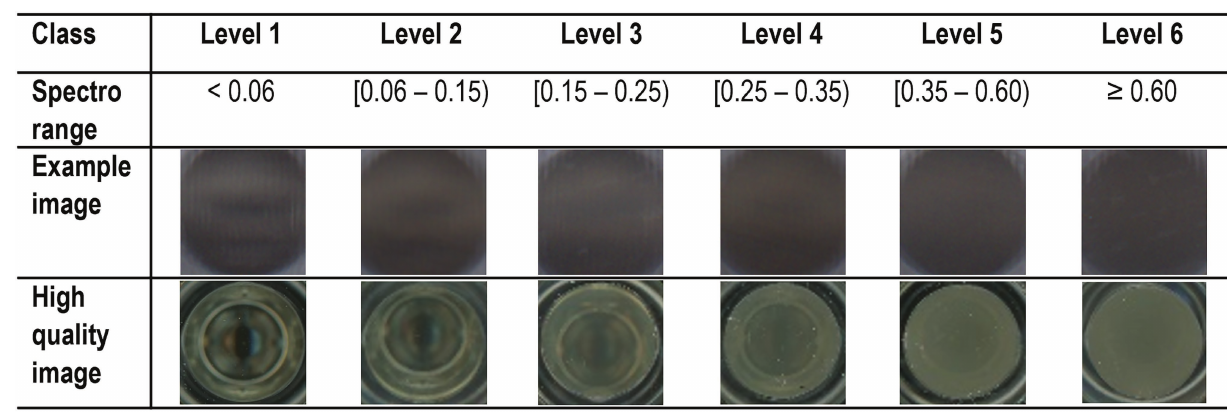
FIGURE 1 | Classification of the scanned images in six classes or levels. Levels were assigned according to the corresponding intervals of spectrophotometric (OD 620 ) values. Each level is represented by an exemplary image of a microplate well containing a culture of Escherichia coli at that specific density stage. All the images used within the ScanGrow application were acquired with a single scanner and presented the same resolution as the upper set of pictures. An additional second set of high-quality images (acquired with a high-end scanner) illustrates how these microplates look under the naked